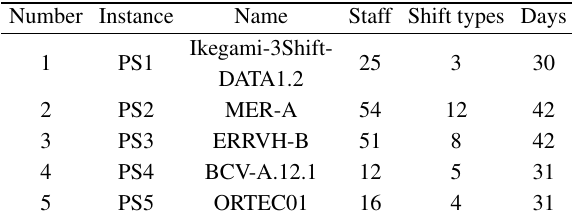
Table 5 Personnel scheduling problem instance.